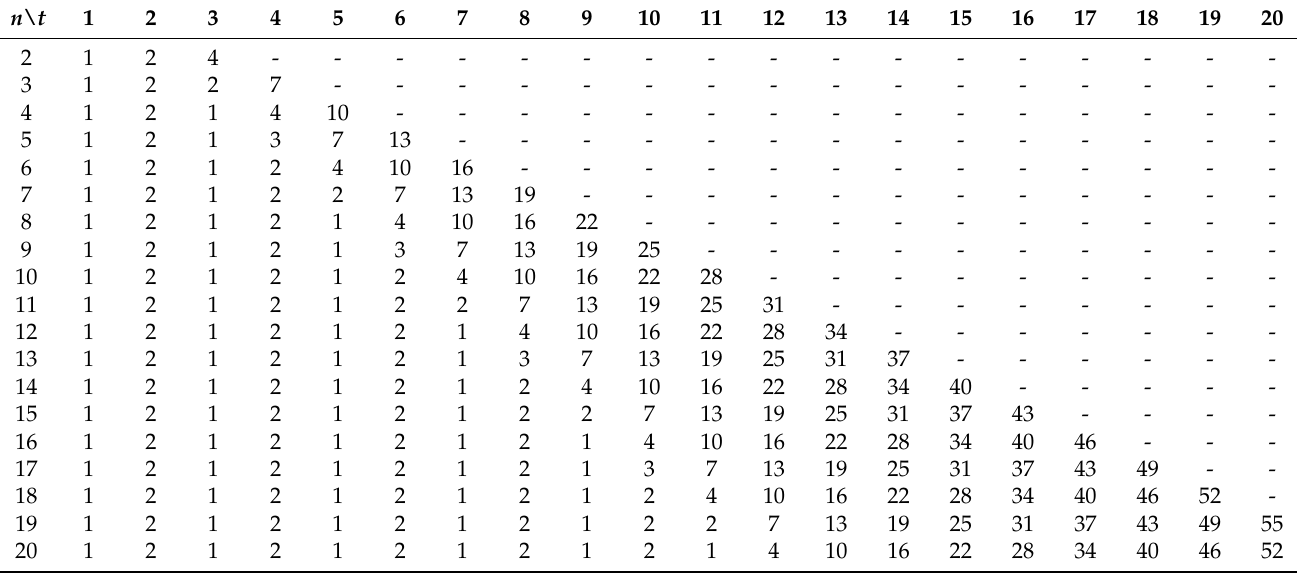
Table 3. Number of connected components of the t -graphs on Z n × Z 3